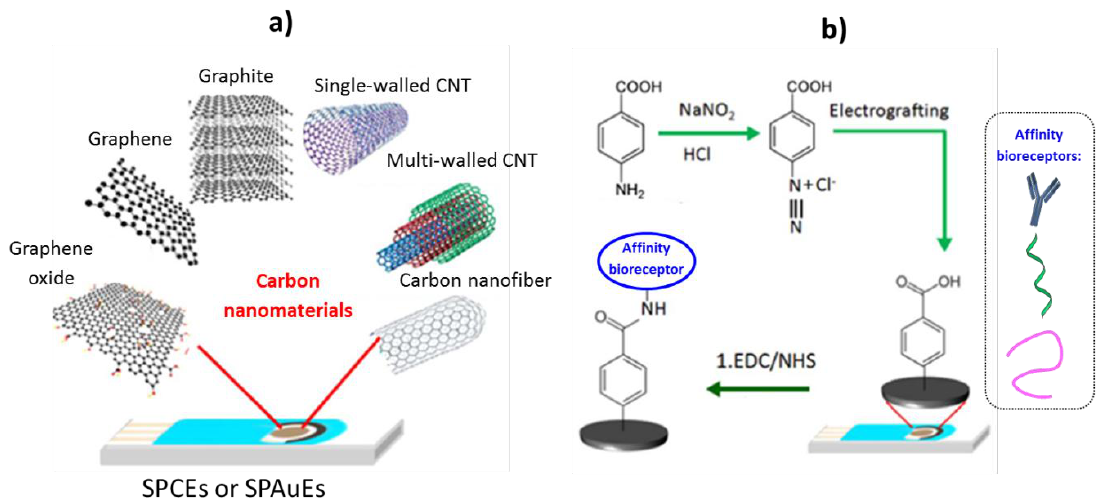
Figure 1. Functionalization of different carbon nanomaterial-modified SPEs ( a ) via diazonium salt reduction and affinity biosensor fabrication ( b ). Reprinted and adapted from [33] with permission.